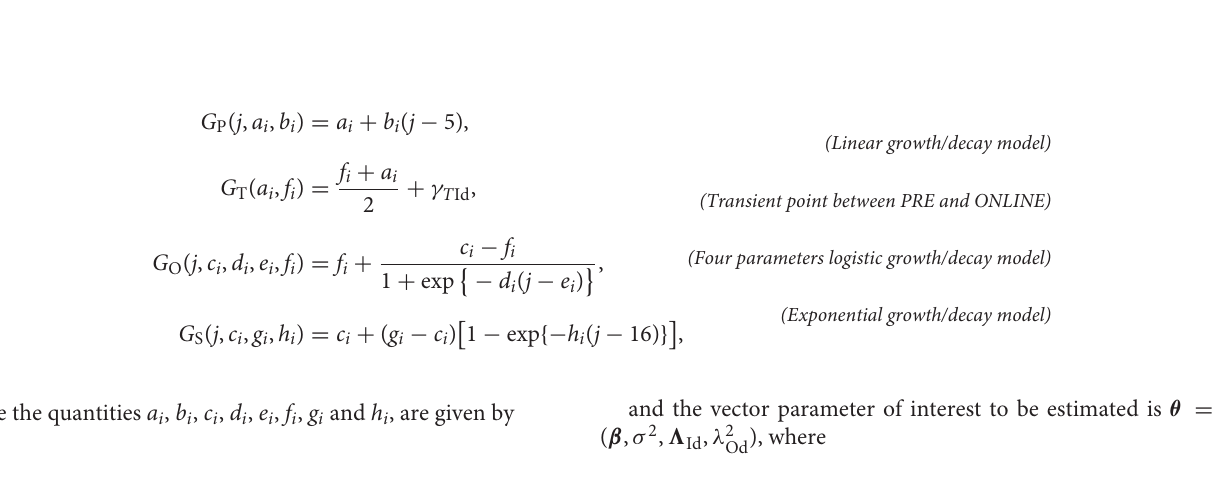
FIGURE 7 | (A) The construction of the response variable was analyzed later. In (a-1) it starts from the response collected in the pilot study (TLQ); In (a-2) the tendency is isolated by extracting the stability point in each segment PRE-ONLINE-POST (obtaining the Detrend TLQ response); In (a-3) reverse the Detrend TLQ response to allow a direct interpretation between “the more, the better” and “the less, the worse” (obtaining the Reverse Detrend TLQresponse); In (a-4) we move the Reverse Detrend TLQ response to the positive axis for mathematical convenience (obtaining the Shifted Reverse Detrend TLQ response, which is equivalent to the previous one). (B) All individual participants in the pilot study. Two patients reported constant response TLQ during all sessions. (C) The box-plots summarize the range of the responses, which highlight the median of treatment responses given periods. (D) The average of all patients, added by one standard